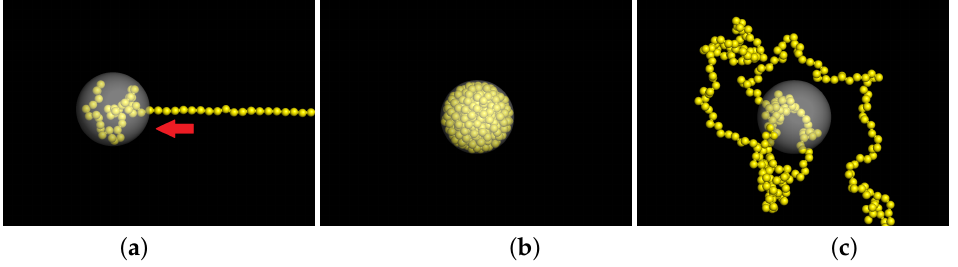
Figure 1. Three phases of simulation: ( a ) the loading phase, in which a chain is loaded into the cavity via a small open pore, ( b ) the equilibrating phase, in which the chain is equilibrated inside the cavity, and ( c ) the releasing phase where the chain is released by switching off the reflection interaction of the cavity wall. The yellow beads represent the monomers of chain. The white sphere represents the cavity. The chain length N is 256 and φ 0 is